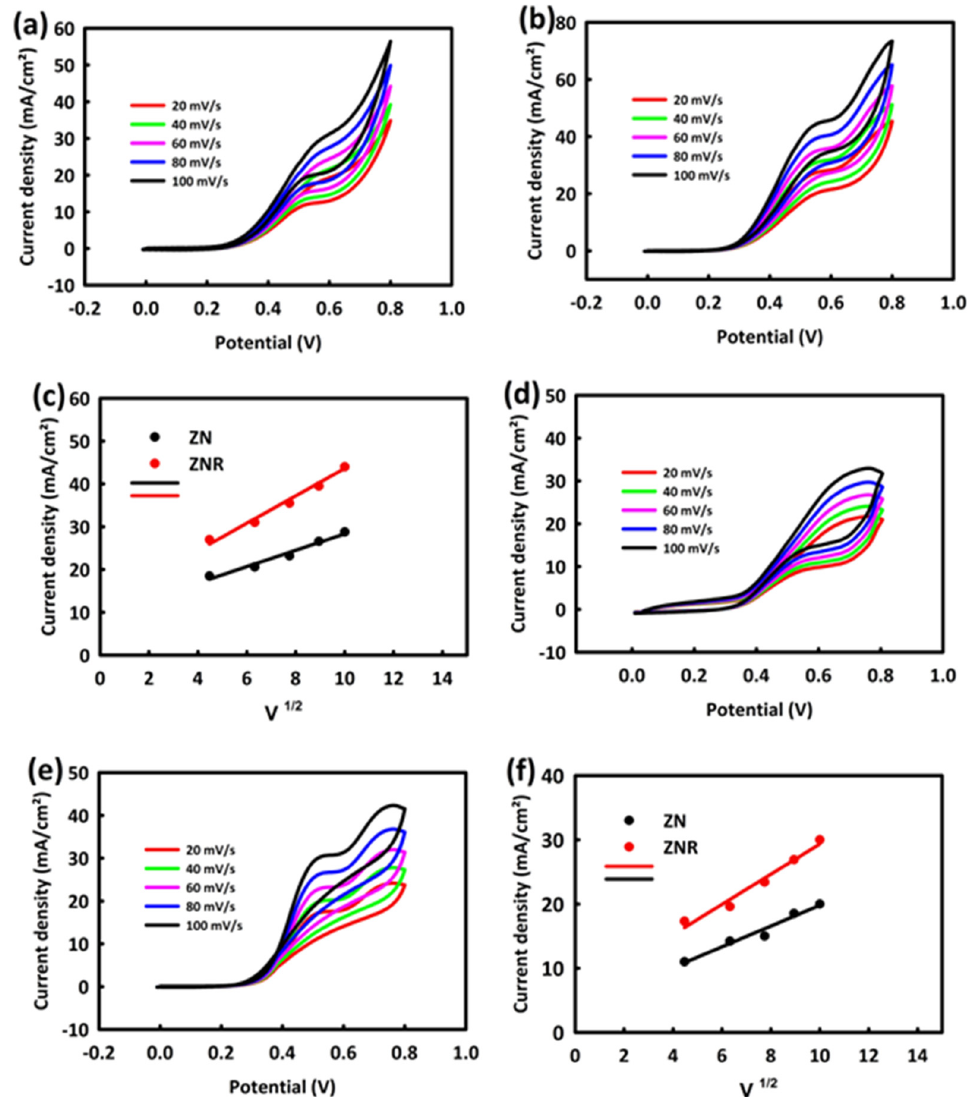
Figure 5. CV from ZrO 2 /NiO ( a ) and ZrO 2 /NiO/rGO ( b ) in 0.5 M KOH/0.7 M methanol/different scan rates. CV from ZrO 2 /NiO ( d ) and ZrO 2 /NiO/rGO ( e ) in 0.5 M KOH/0.5 M ethanol/different scan rates. The plot of the square root of scan rate in terms of maximum current density for ZrO 2 /NiO and ZrO 2 /NiO/rGO in MOR ( c ) and in EOR ( f ).